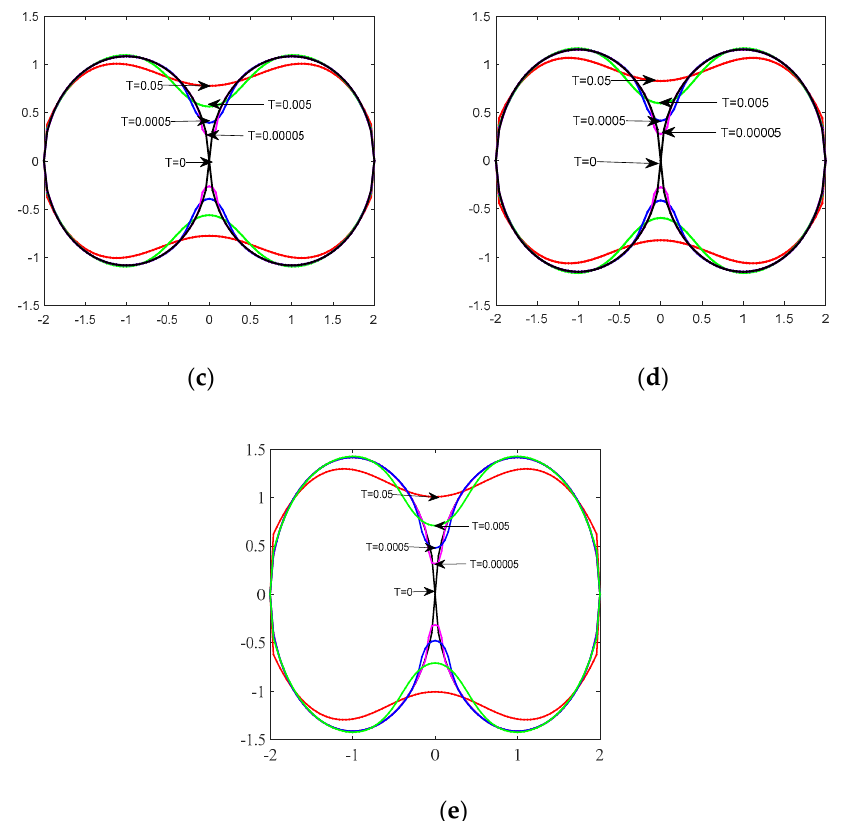
Figure 5. Sintering neck growth of two metal fibers with di ff erent fiber angles: ( a ) α = 0; ( b ) α = π / 6; ( c ) α = π / 4; ( d ) α = π / 3; ( e ) α = π / 2. T = time.